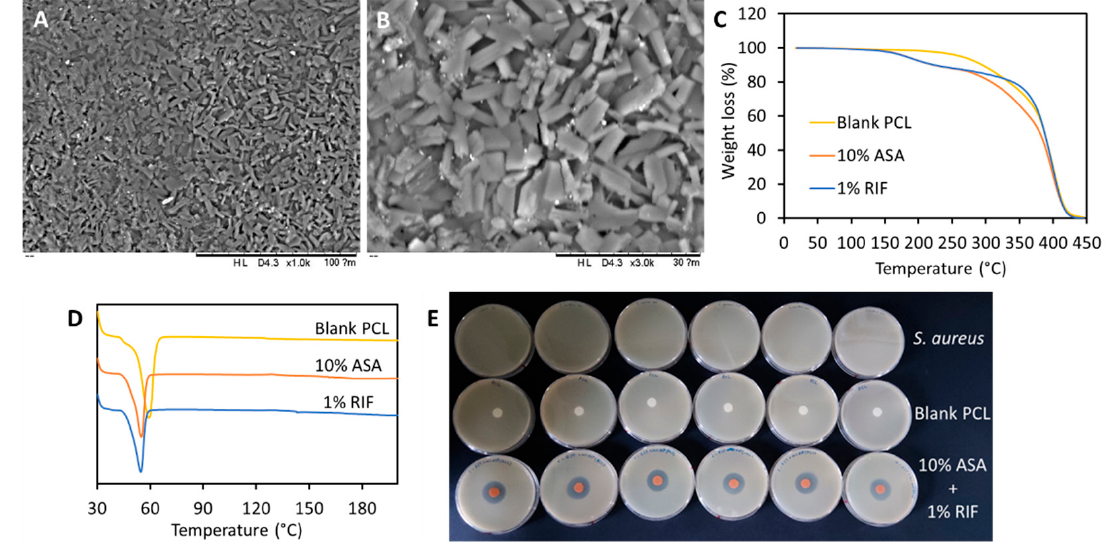
Figure 7. SEM image of 3D-printed samples containing 10% ( w / w ) of ASA and 1% ( w / w ) RIF ( A , B ). TGA ( C ) and DSC ( D ) curves for 3D-printed samples containing different amounts of RIF and ASA. A photograph showing the zones of inhibition obtained for MRSA in MH agar obtained using different 3D-printed samples ( E ).